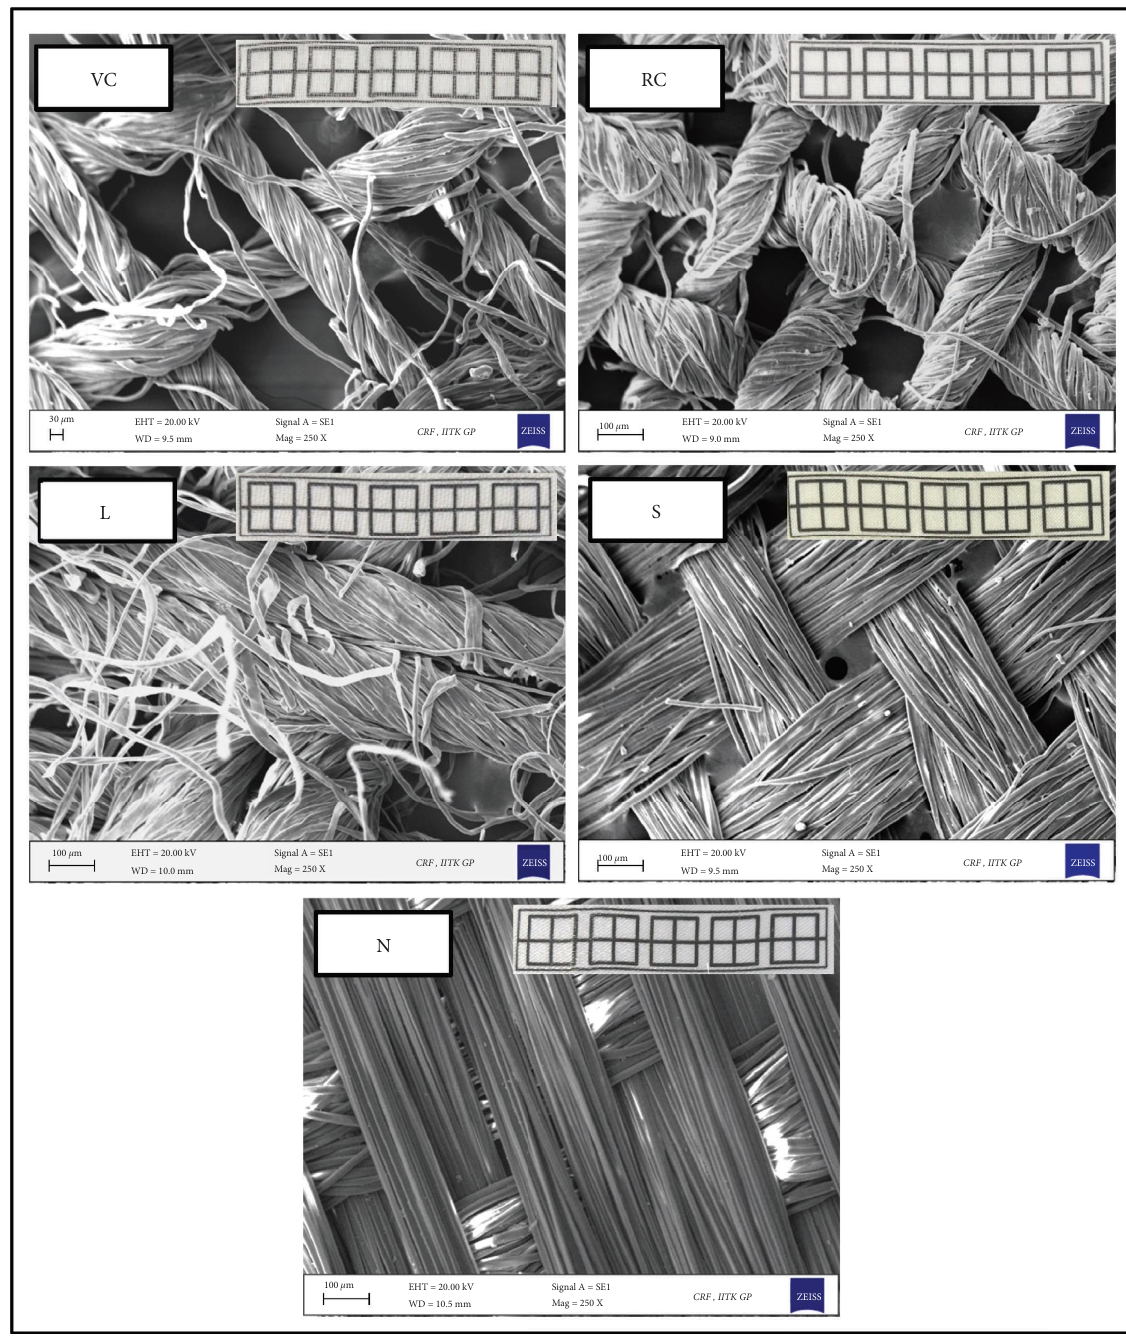
Figure 2: Scanning electron micrographs of the selected textiles (scale bar: 100 μ m). Inset: camera images of the prepared textile-based